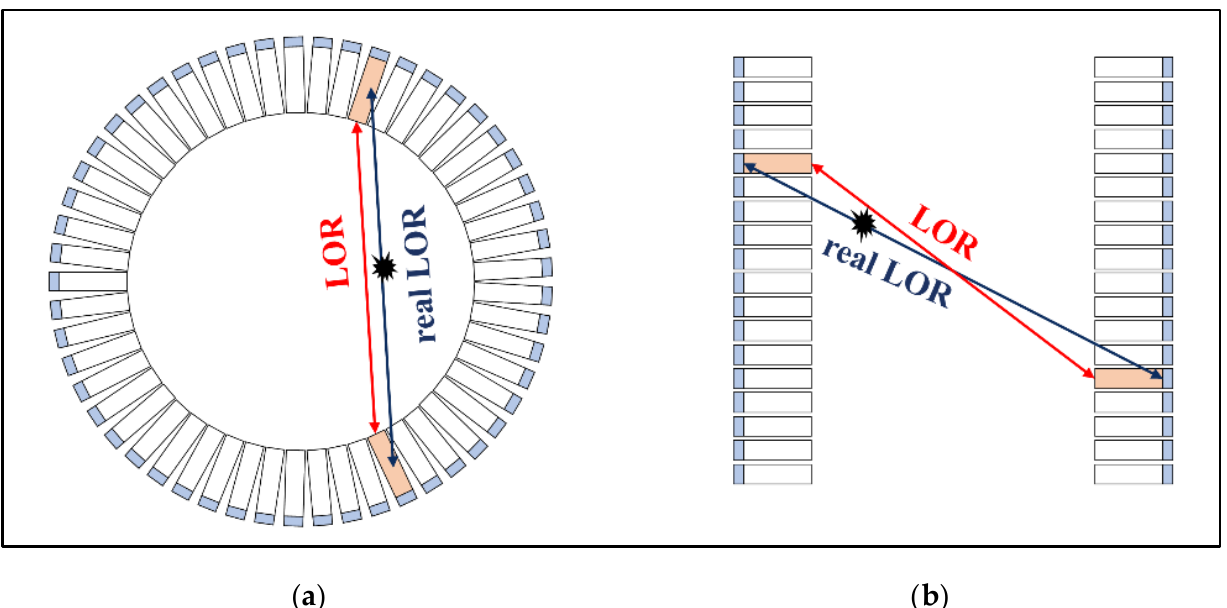
Figure 4. ( a ) Parallax error in the LOR in the radial direction caused by the DOI; ( b ) Parallax error in the LOR in the axial direction caused by the DOI.